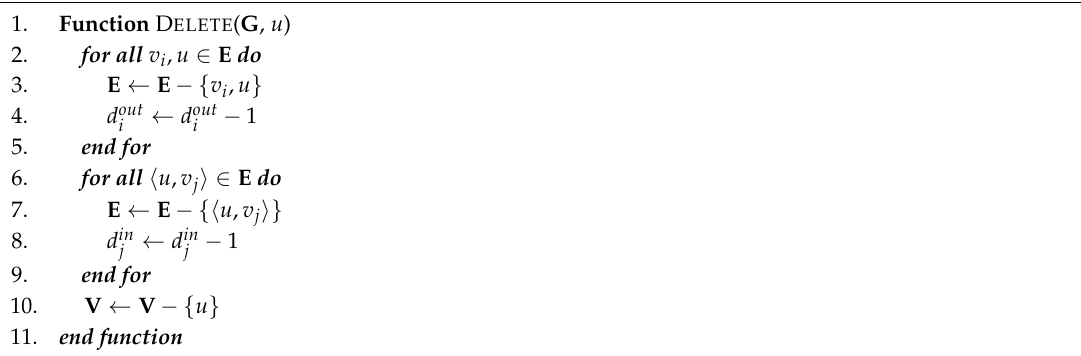
Algorithm 3. Delete a Vertex from a Weighted